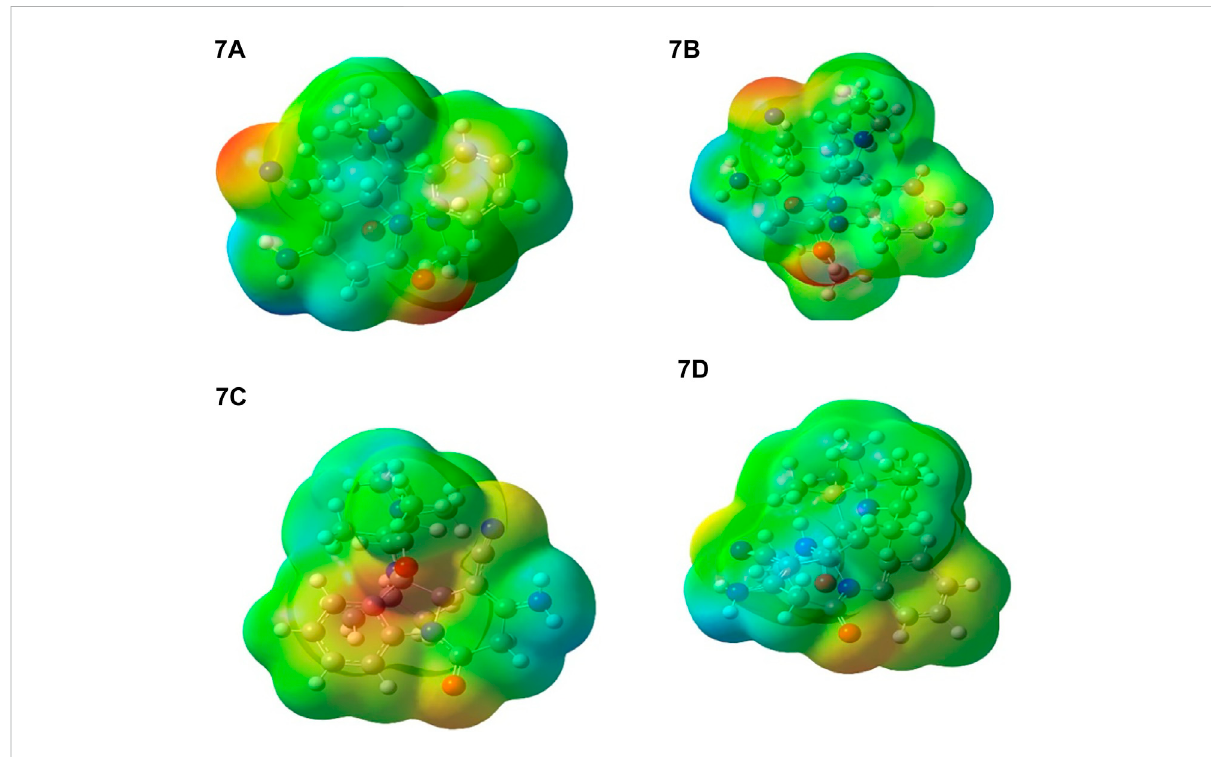
FIGURE 12 Calculated molecular electrostatic potential surfaces for